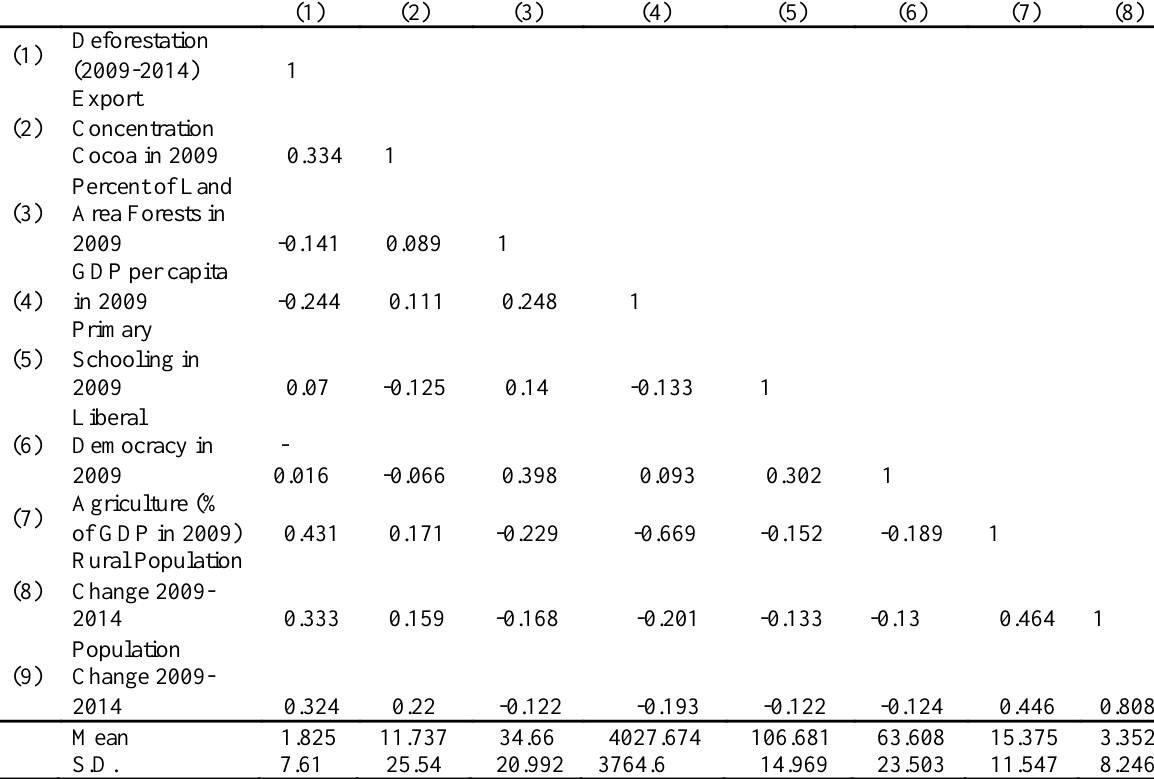
Table 6. Correlation Matrix, Means, and Standard Deviations for 5-Year Deforestation Ending